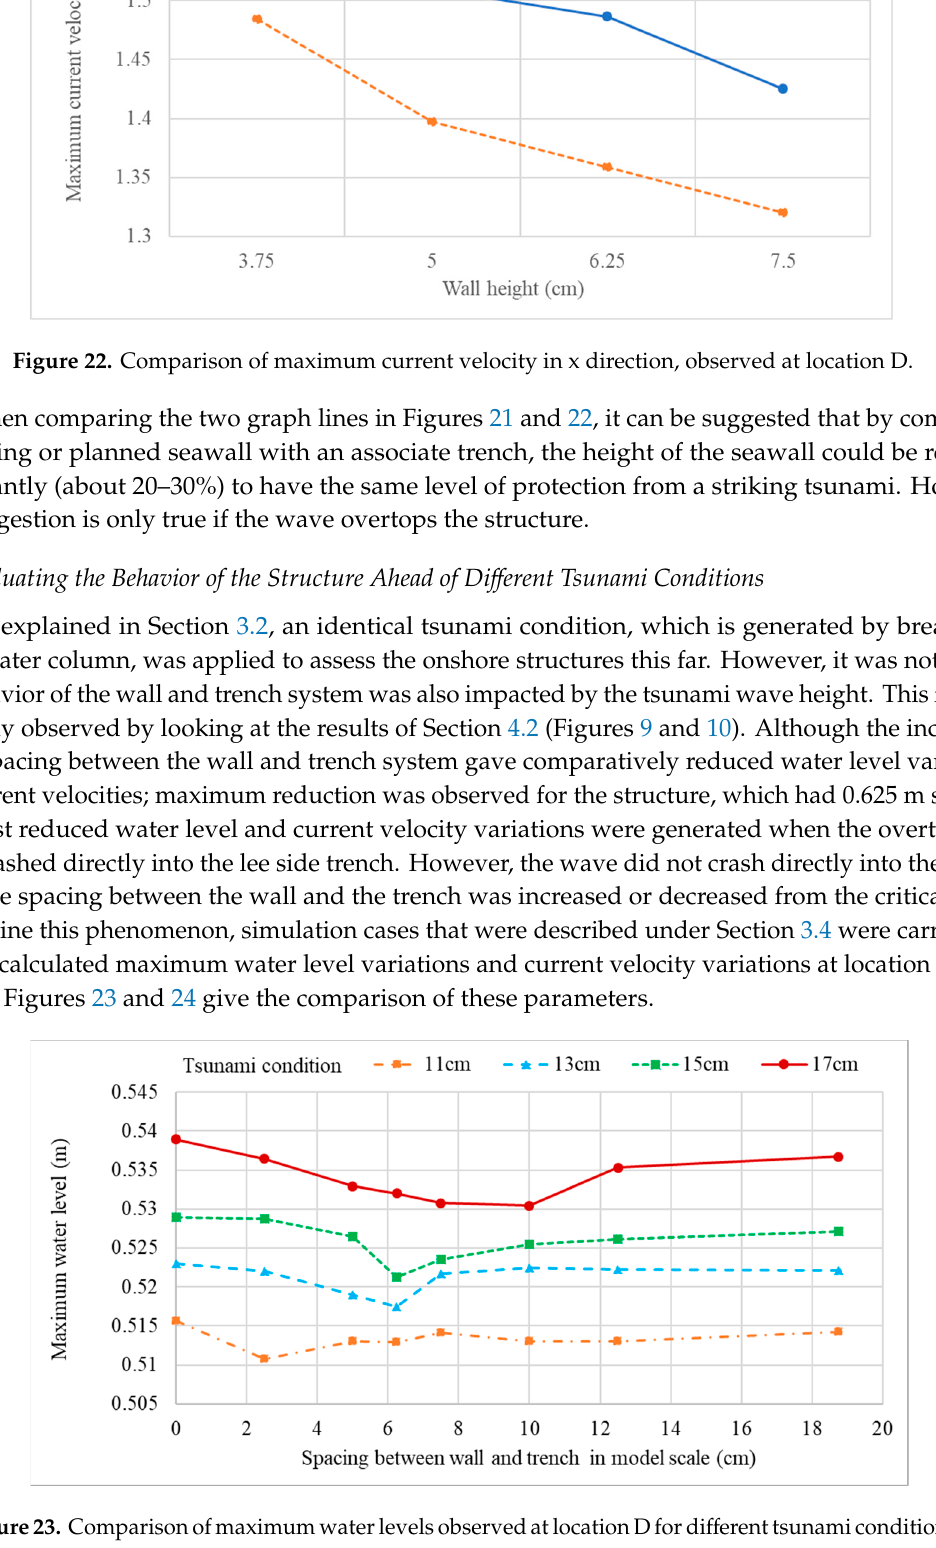
Figure 24. Comparison of maximum current velocity in x direction, observed at location D for different tsunami conditions. Figures 23 and 24 show the impact of spacing between the wall and the trench of the structure system onshore in regard to water level and current velocity reduction. When a tsunami with a comparatively low wave height (0.11 m case) strikes, the overtopping wave front does not travel too far before it collapses to the lee side of the wall. Thus, 0.05 m spacing between the wall and the trench is enough to capture the collapsing wave. When the wave height of the tsunami increases, the travelling distance of the overtopping wave front is also increased and therefore, the spacing between the wall and the trench should also be increased to capture the collapsing wave to generate more turbulence to depress the wave energy. Figures 25–27 give the snapshots of current velocity vectors for three selected simulation cases with different spacings between the wall and the trench (spacings of 0 cm, 6.25 cm and 18.75 cm) under 13 cm tsunami condition. All snapshots were captured at the same simulation time (t = 13.2 s). Readers can get an idea on how the overtopping wave behave when it directly collapses in to the lee side trench and when it does not as explain above. Simulation cases (Case. 24, 36 and 52) with 13 cm tsunami condition are presented in following 3 figures consecutively.